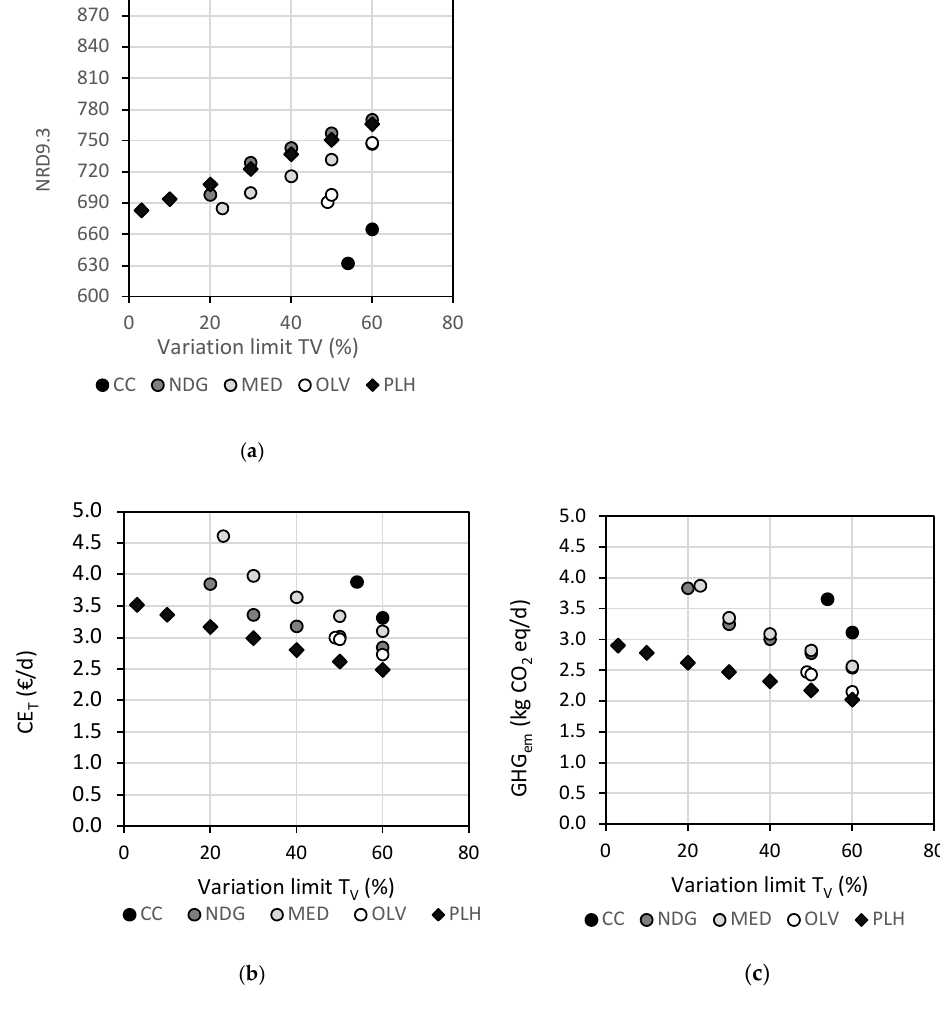
Figure A3. Optimization of the diets according to nutritional ( a ), economic ( b ), and environmental ( c ), targets as functions of the acceptability variation limits.